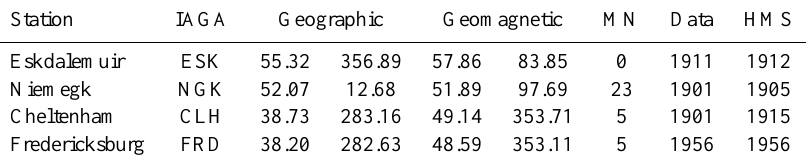
Table 1. Information on stations used. Magnetic coordinates are calculated using the IGRF 2000 model. MN hour indicates the local mid-night hour in UT, and HMS start stands for the year when hourly mean sampling started. At ESK HMS probably started in